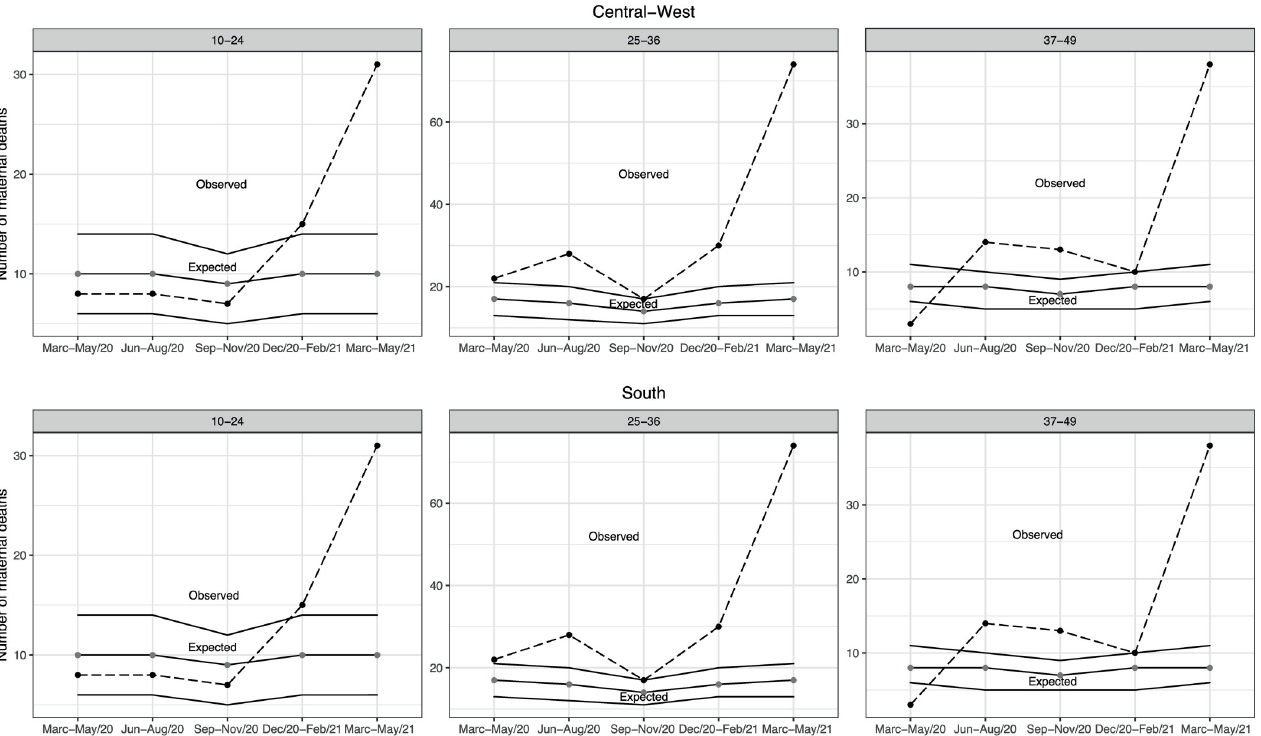
Fig 2. Observed and expected maternal deaths according to age group and five consecutive trimonthly periods, Central-West and South Regions, Brazil 2020–2021.